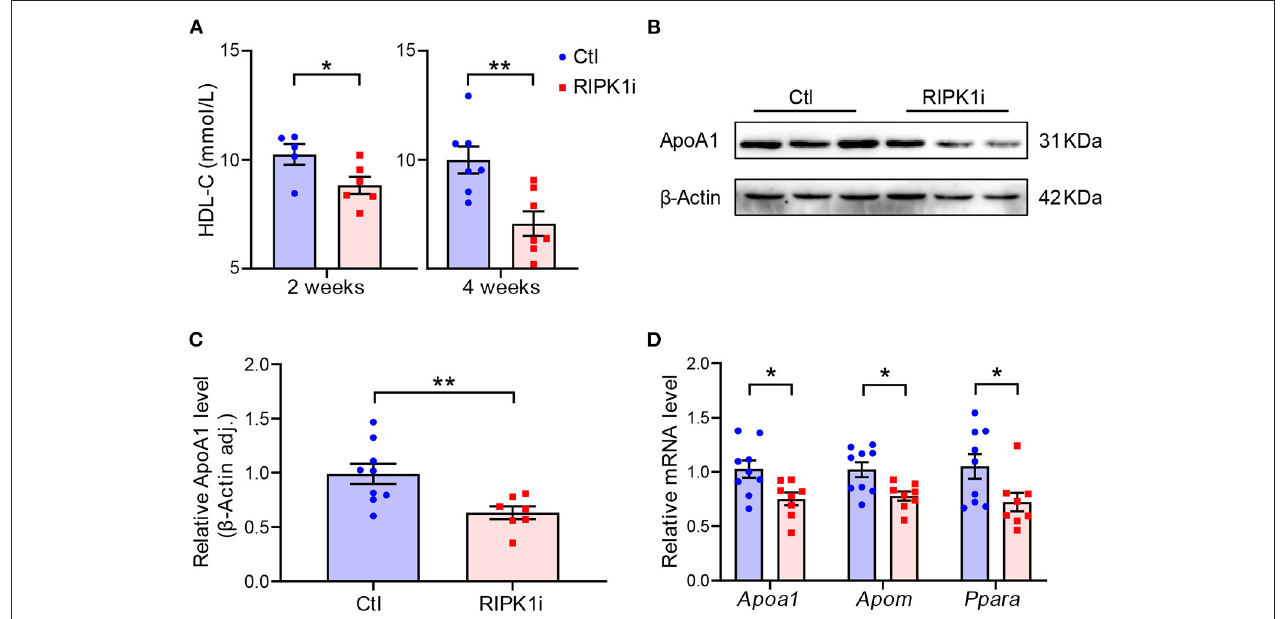
FIGURE 3 | RIPK1i treatment decreased plasma HDL and suppressed liver ApoA1 expression level. (A) Plasma HDL-C level in male ApoE SA / SA mice fed with WD and Dox for 2 and 4 weeks. n = 5–8 mice per group. (B) Representative Western blot images of ApoA1 from liver of male ApoE SA / SA mice fed with WD and Dox for 2 weeks. (C) Quantification of liver ApoA1 protein level ( n = 9.7). (D) qRT-PCR analysis of Apoa1 , Apom , Ppara in liver of male ApoE SA / SA mice fed with WD and Dox for 2 weeks ( n = 9.8). All of the data represented as mean ± SEM; * P < 0.05, ** P < 0.01. Statistical analysis: unpaired student’s t